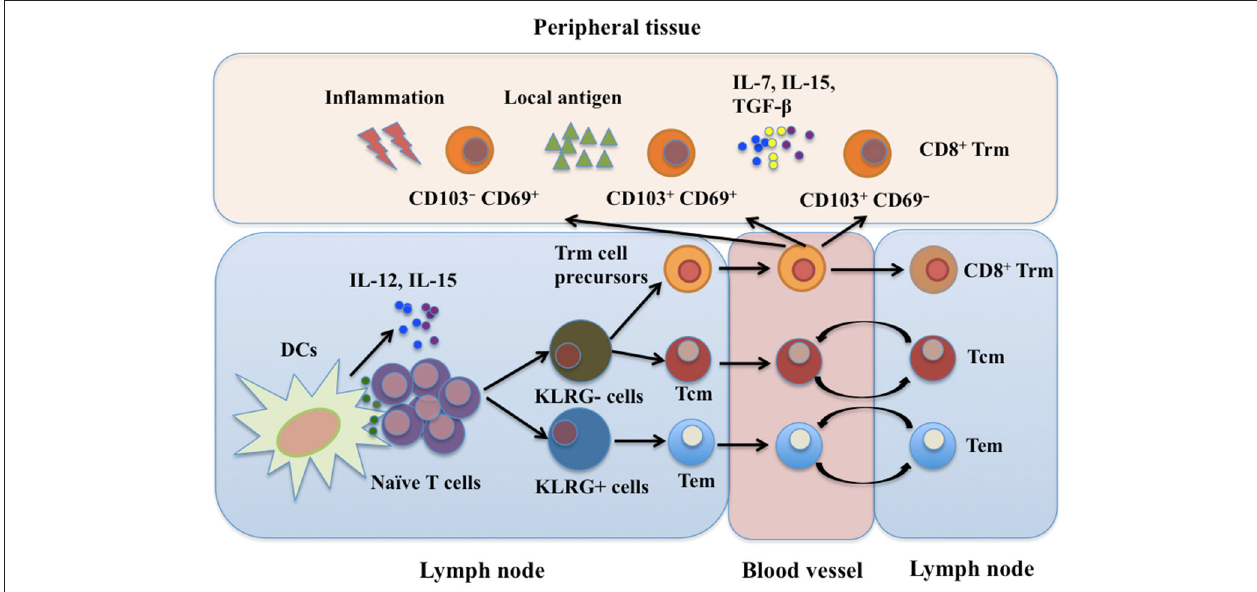
FIGURE 1 | CD8 + Trm cell development. Trm, Tem, and Tcm cells are derived from the same naïve T cell clone upon activation in SLOs. CD8 + Trm cell precursors migrate into peripheral tissues as well as SLOs where they differentiate into Trm cells. Currently, at least three subtypes of CD8 + Trm cells have been identified: CD103 + CD69 + , CD103 + CD69 − , and CD103 − CD69 + Trm cells. Local microenvironment, including cytokines, local antigens and inflammatory mediators, is important for development of CD8 + Trm cells. SLOs, secondary lymphoid organs; Tcm, central memory T cells; Tem, effector memory T cells; Trm, resident memory T cells; DCs, dendritic cells; LN, lymph node; IL-7, interleukin-7; IL-12, interleukin-12; IL-15, interleukin-15; TGF- β , transforming growth factor- β ; KLRG, killer cell lectin-like receptor